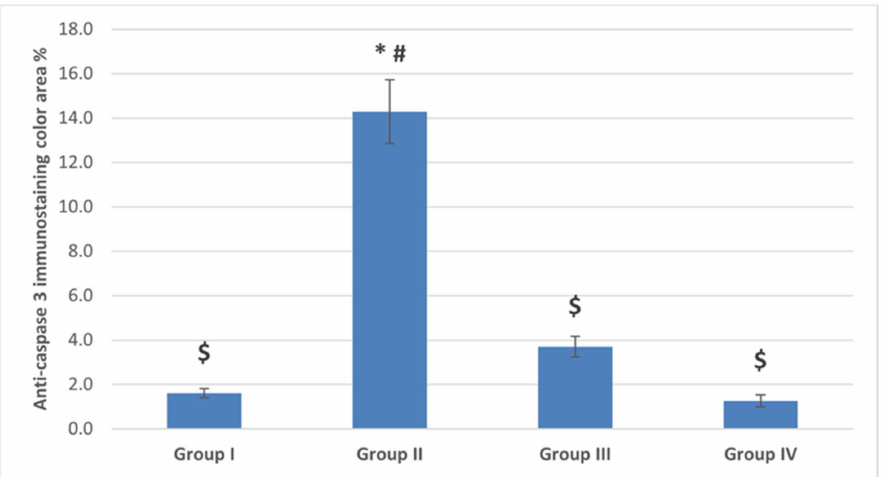
Figure 11. The mean color area percentage of anti-caspase 3 immunostaining. Data are expressed as means ± SEM ( n = 6) and analyzed using one-way ANOVA followed by post-hoc Bonferroni multiple comparison test. (Symbols: *: p ≤ 0.05 compared to the control group (Group I); $: p ≤ 0.05 compared to the POI group (Group II); #: p ≤ 0.05 compared to diosmin 50 group (Group III)).